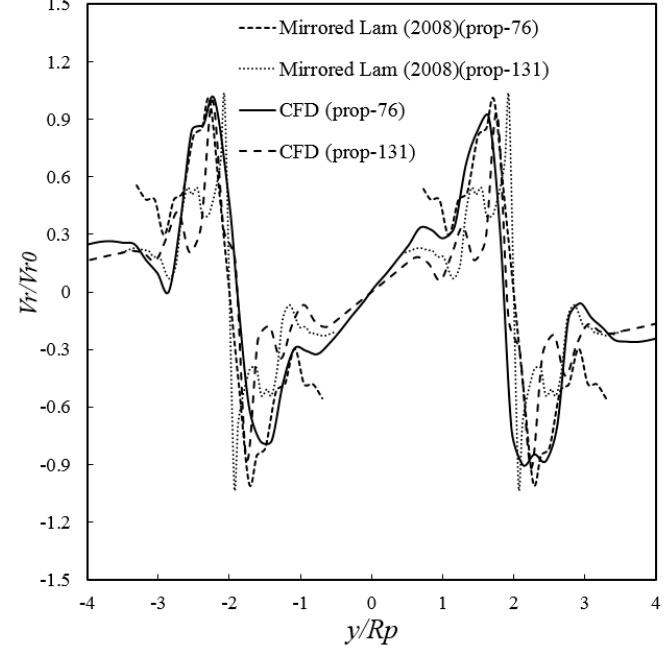
Figure 13. Radial velocity distributions at the efflux plane.